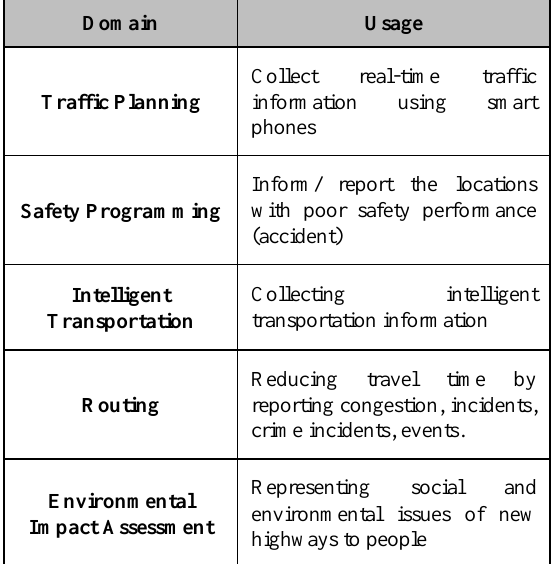
Table 2. Public participation in transportation domains Domain